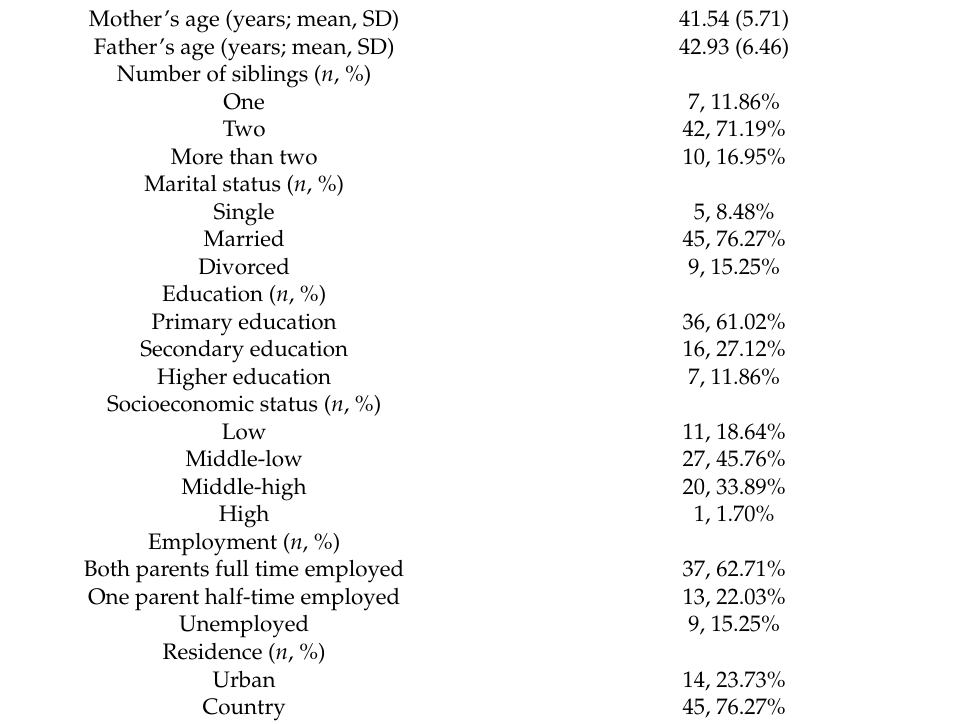
Table 1. Families’ sociodemographic characteristics.